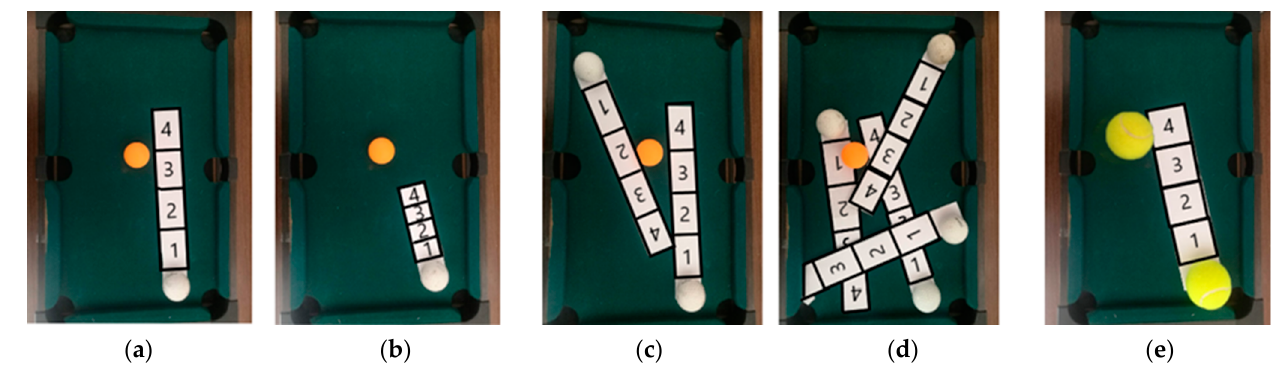
Figure 9. Balls on a pool table modeling the probability of collision (virus transmission) under the different conditions of population density, population mobility, and use or not of face masks. They represent: ( a ) kid running, ( b ) adult walking, ( c ) and ( d ) many people moving fast, ( e ) without masks.